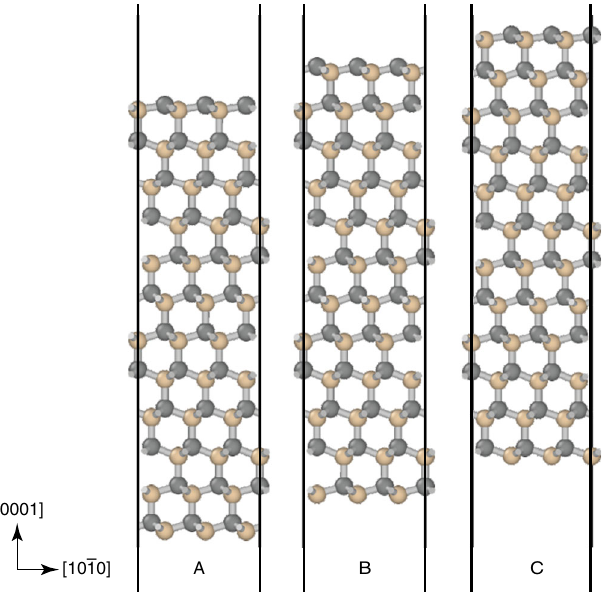
Fig. 5 Relaxed structure of the 6H-SiC (0001) surface. There are three inequivalent basal cleavage planes for 6H SiC, which we fi nd to be very close to degenerate in surface energy: 2 γ = 8.58 ± 0.04 J m − 2 with LDA and 7.71 ± 0.04 J m − 2 with GGA. The upper surfaces are C-terminated and